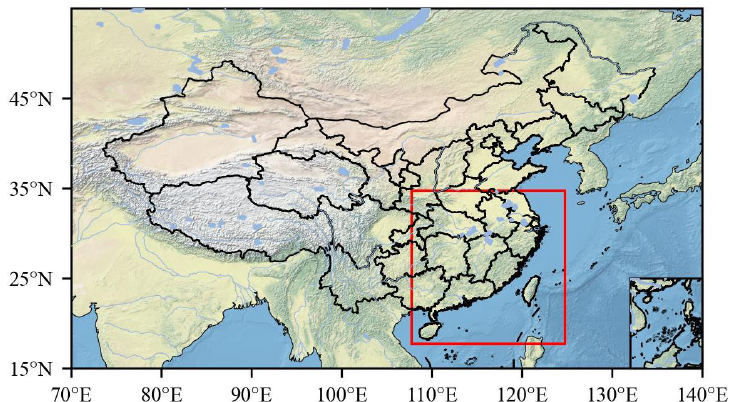
Figure 1. The schematic diagram of the study